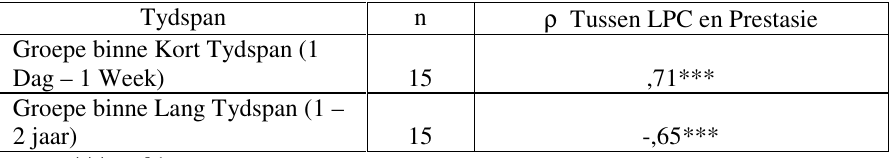
RANGORDEKORRELASIE TUSSEN LPC-TELLINGS VAN